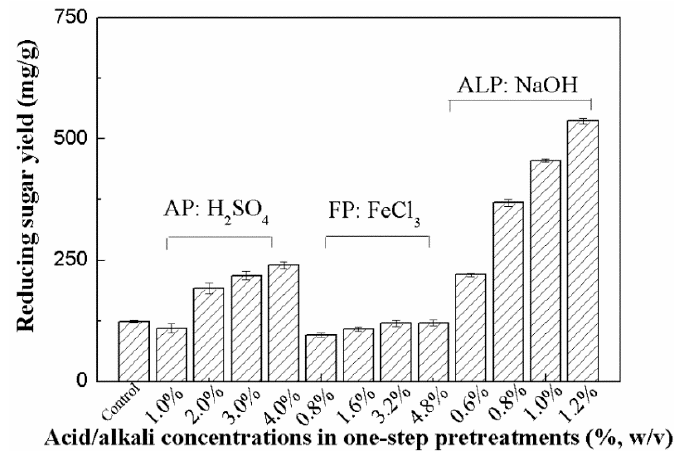
Figure 2. Effect of AP, FP, ALP on enzymatic hydrolysis (Note: The levels of reducing sugars were determined by DNS assay ) .